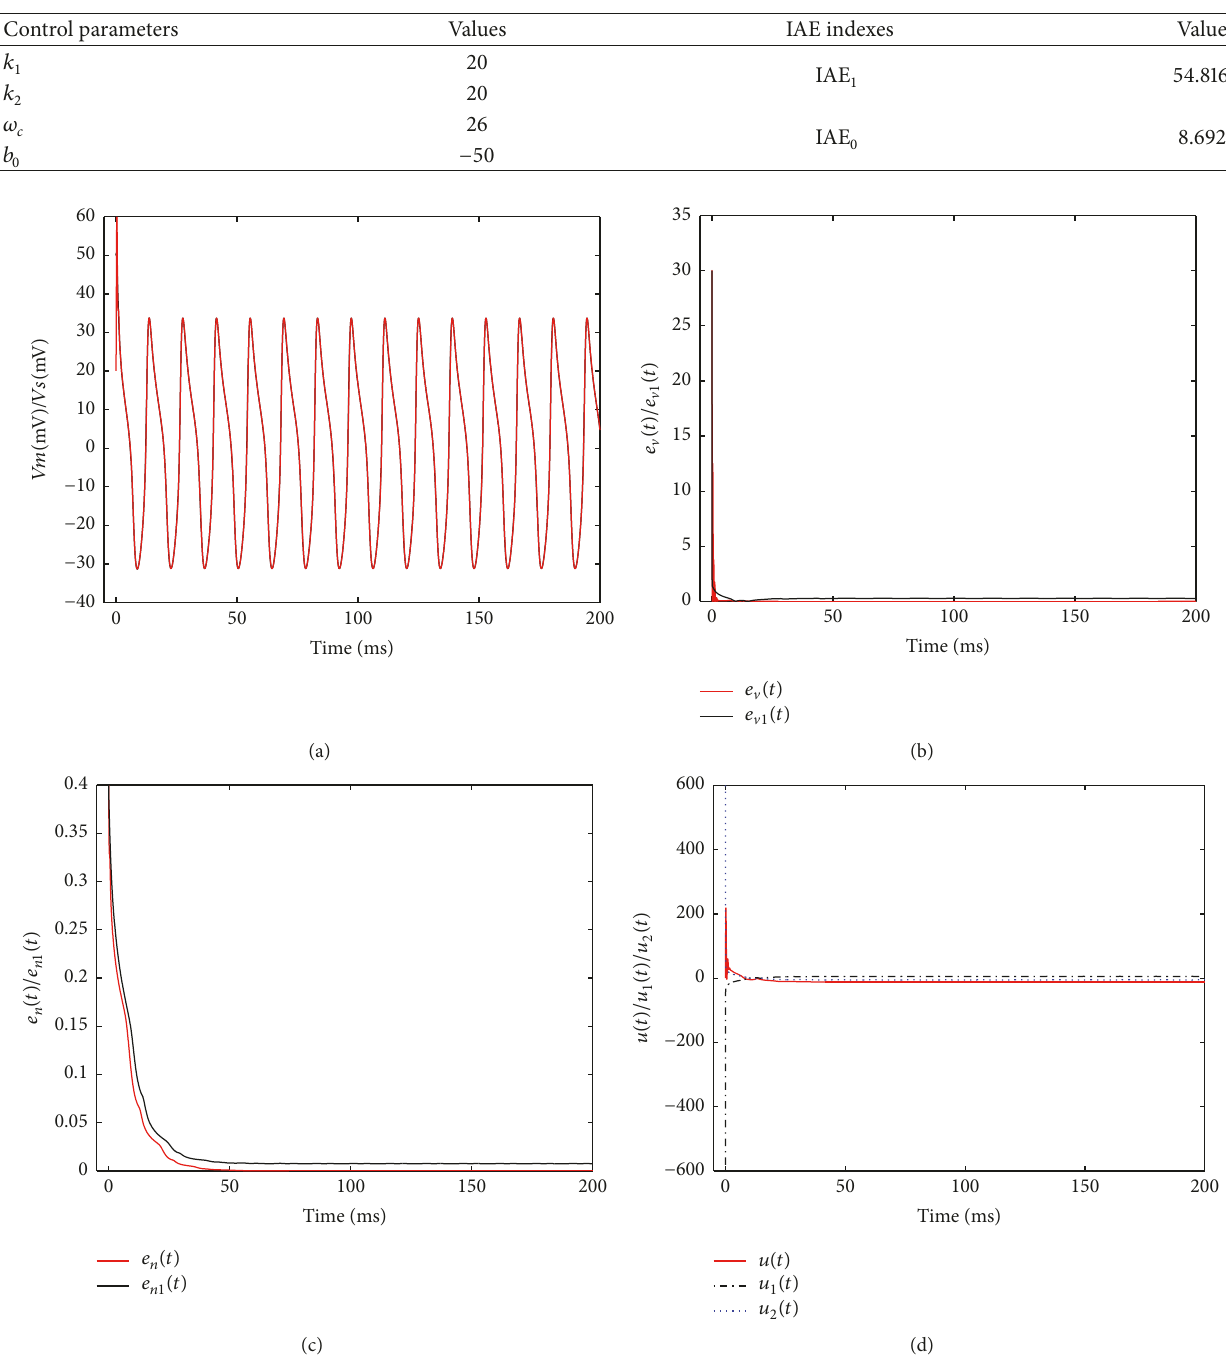
Table 2: Control parameters and IAE values (in absence of disturbance).